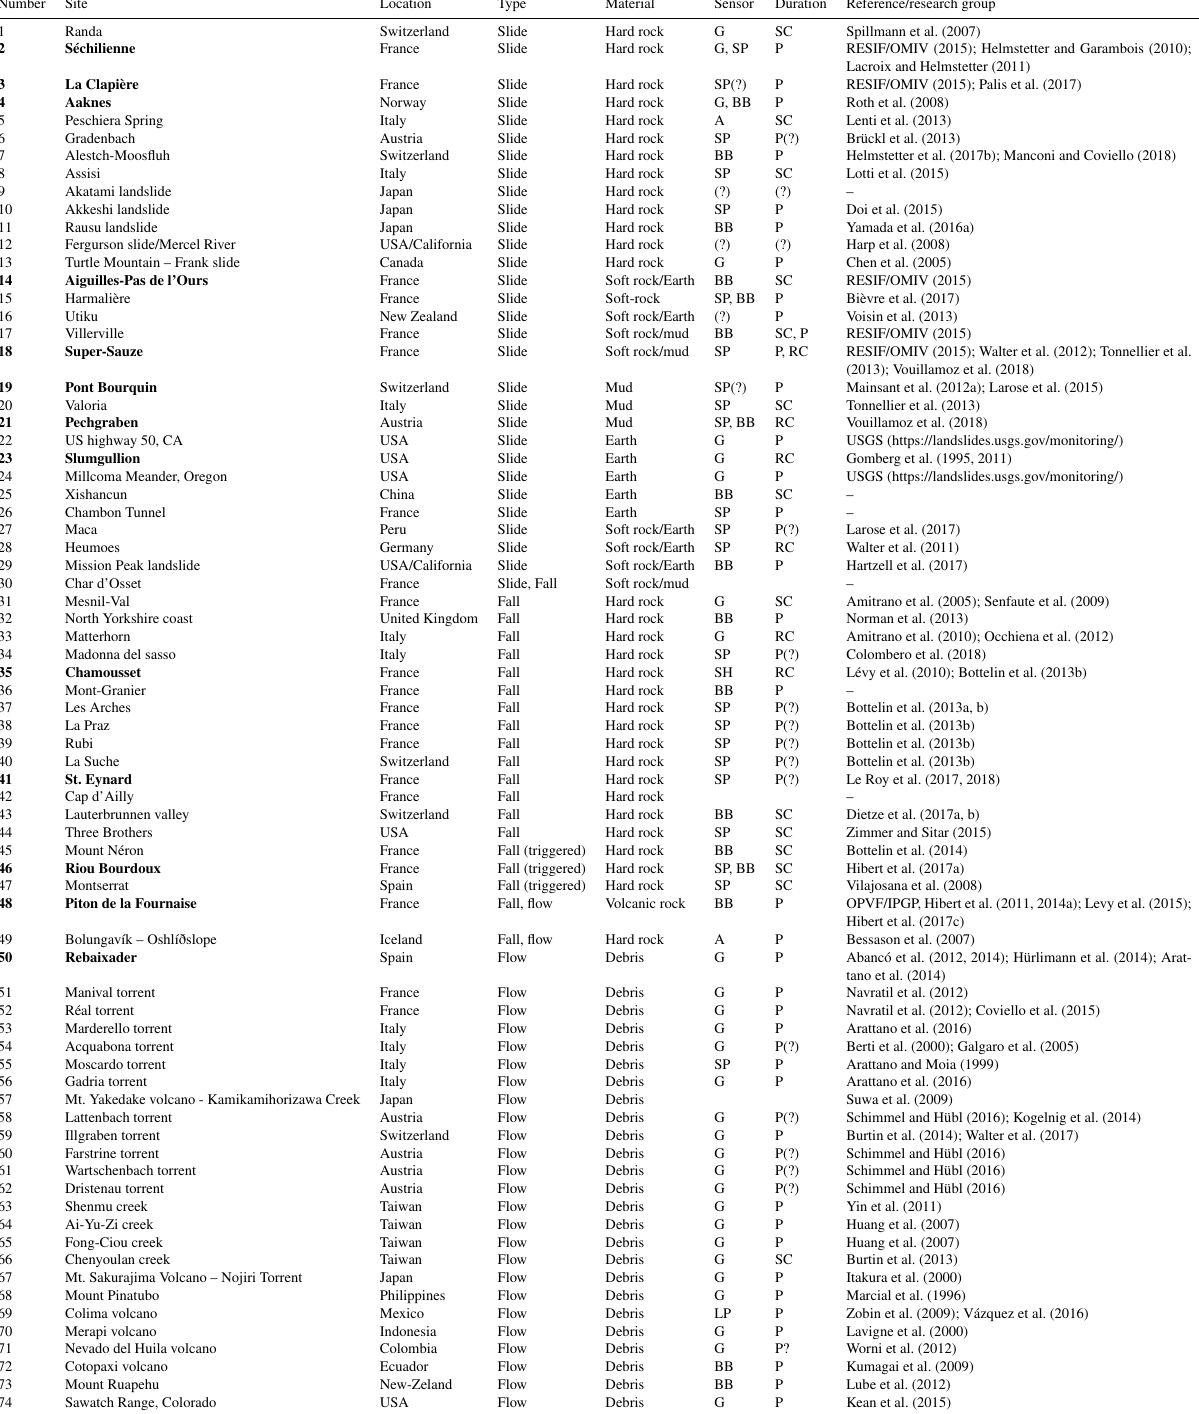
Table 1. Table of the instrumented sites. The bolded names correspond to the sites investigated in the present paper to establish the